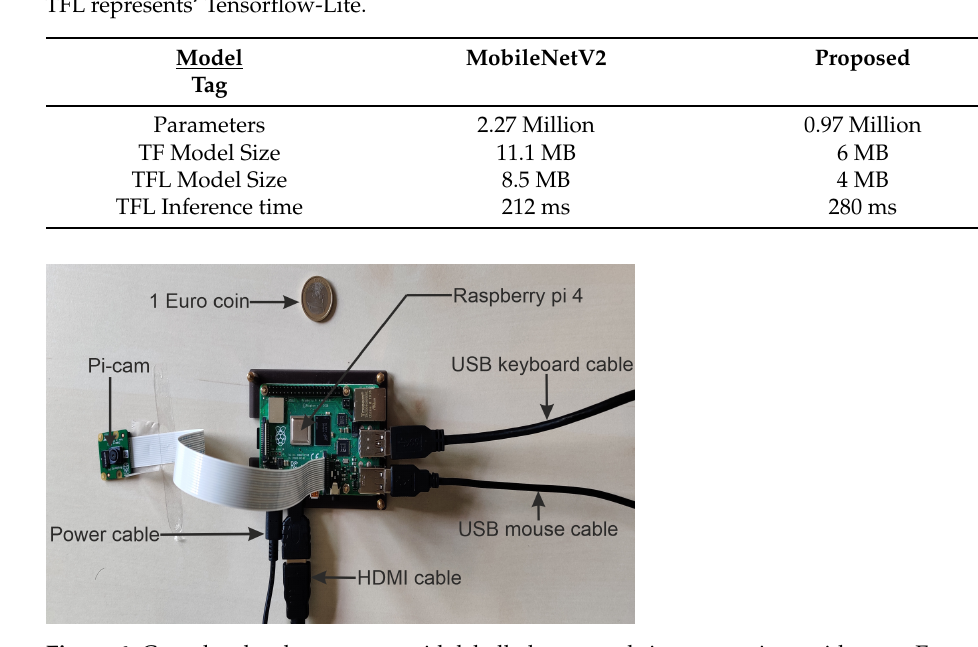
Figure 6. Complete hardware setup with labelled parts and size comparison with a one Euro